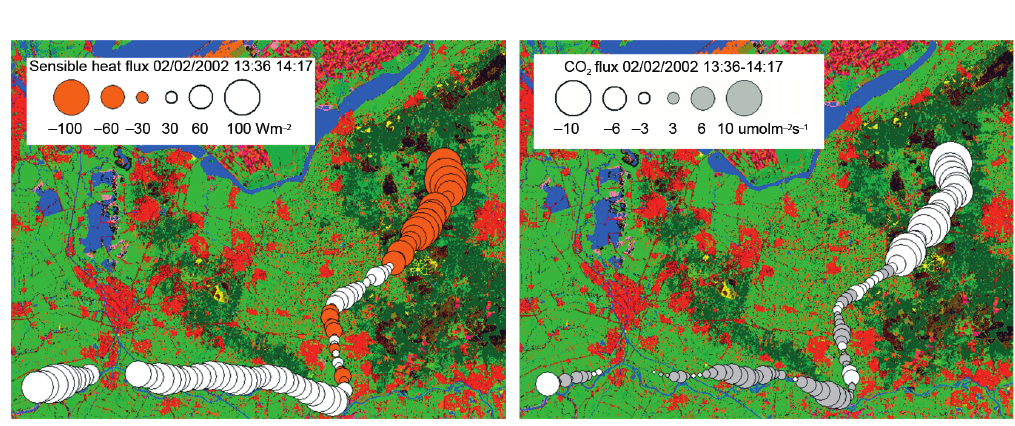
Fig. 2. Sensible heat and CO 2 measured fluxes, plotted on land cover map of the region. Bubble diameter is rel- ative to flux magnitude. Dark green patches rapresent forest type ecosystems, light green agricultural type ecosystems, and red urban